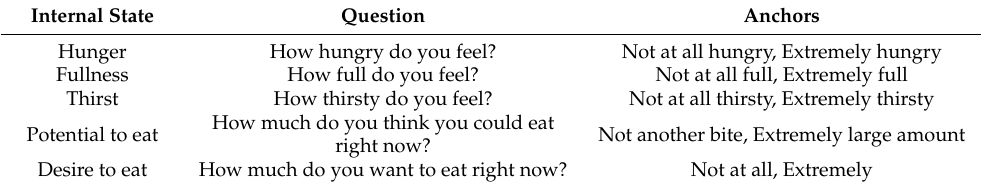
Table 1. Questions and anchors for the internal state rating scales.